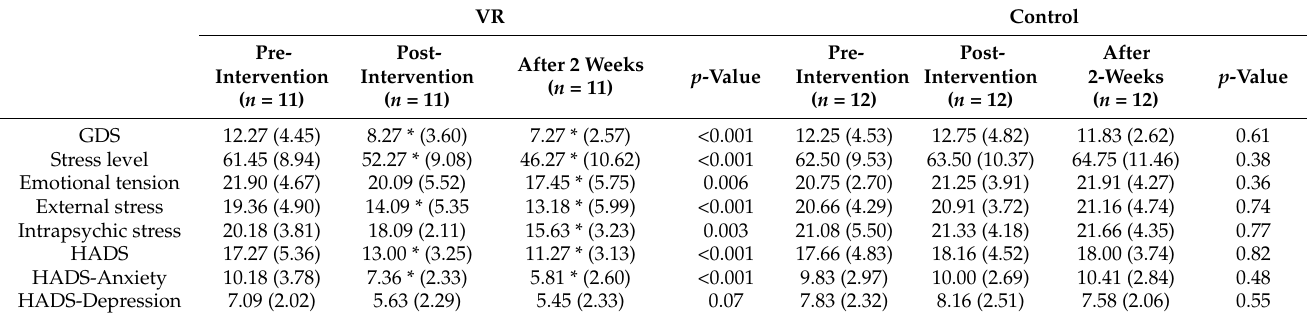
Table 2. Primary and secondary outcome measures results, mean